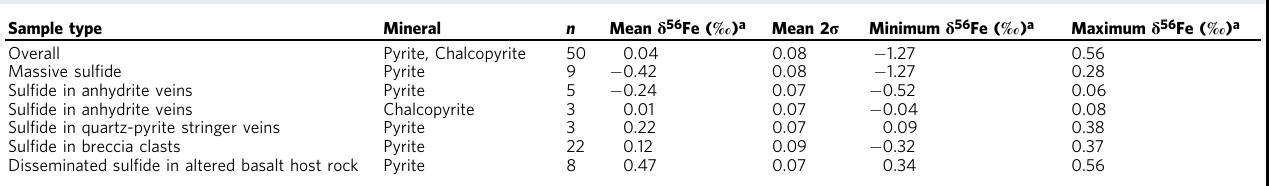
Table 1 Summary of iron isotope data for TAG sul fi des. Sample